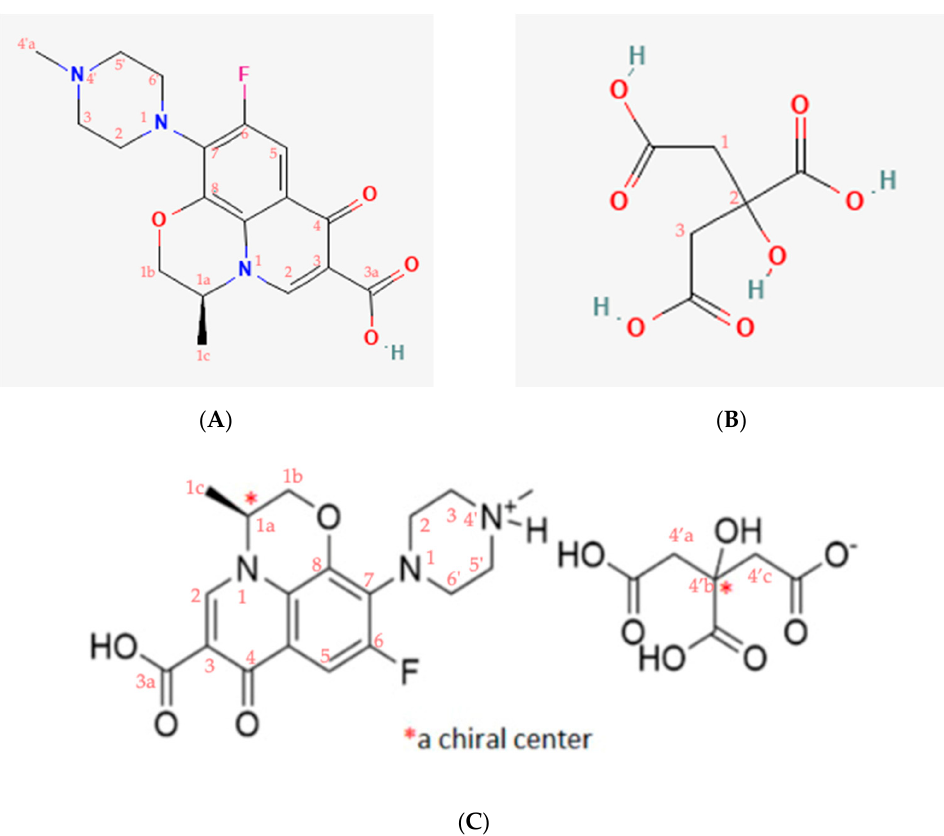
Figure 7. Numbering molecule structure of ( A ) levofloxacin/LF, ( B ) citric acid/CA, and ( C ) levofloxacin citrate/LC.